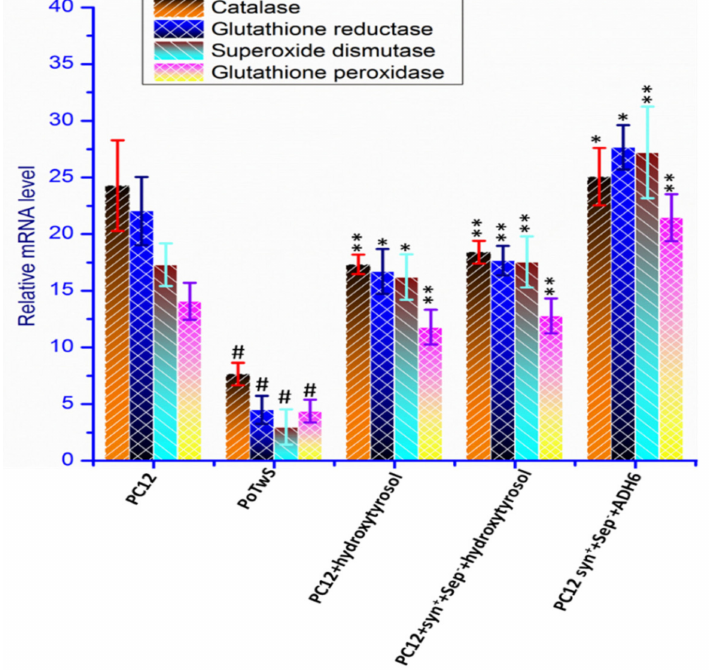
Figure 5. Comparative qPCR analysis. The transcription level of CAT, GSH, SOD, and GPx was determined in PC12 cells, PoTwS cells, and the PC12 + hydroxytyrosol, PC12 + syn + + sep − + hydroxytyrosol, and PC12 + syn + + sep − + ADH6 cell lines. The maximum improvement in the transcription level of CAT, GSH, SOD, and GPx was observed in the PC12 + syn + + sep − + ADH6 cell line compared to PoTwS cells. The description of each cell line is given in Supplementary Table S3. Data are mean and S.E. values from three independent experiments ( n = 3). # p < 0.01, relative to PC12 (control cells). * p < 0.05 and ** p < 0.01, relative to the cells treated only with